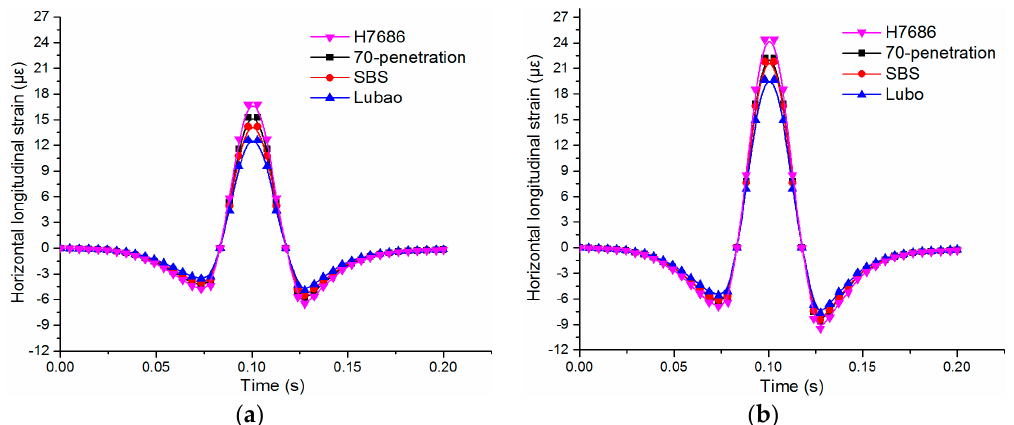
Figure 8. Horizontal longitudinal tensile strains at the bottom center of underlayers: ( a ) under standard load; ( b ) under heavy load.